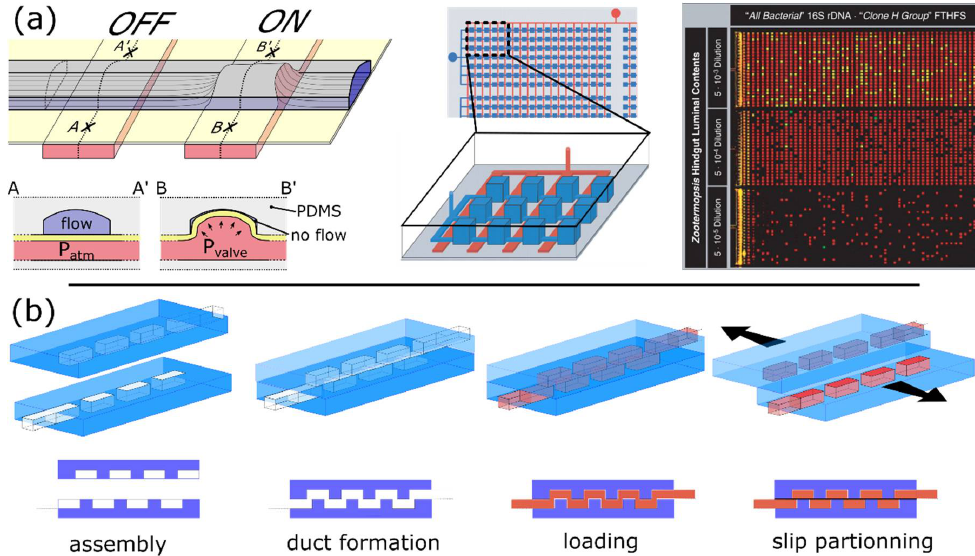
Figure 6. Active partitioning platforms. ( a ) Schematic of a push-up valve in a microfluidic chip made of PDMS. Left panel: The control channels (red) are separated from the fluidic channels (blue) by a thin flexible membrane (yellow). The flow through the fluidic channel is unobstructed if the control channel is not pressurized (OFF valve). When the control channel is pressurized, the thin PDMS membrane deforms and bulges into the fluidic channel, obstructing the flow (ON valve). As depicted in the bottom panel, a tight seal is obtained if the top of the fluidic channel is rounded. Central panel: Schematic diagram showing many parallel chambers (blue) connected through channels to a single input. The network of control channels (red) creates valves between each chamber allowing the partitioning of their content into independent PCR microreactors. Right panel: Three panels of 1176 chambers each, show the results of dPCR on samples harvested from a single termite ( Z. nevadensis ). (Figure adapted from [65] with permission.); ( b ) SlipChip device relies on two chip halves that contain arrays of open chambers. Temporary ducts or channels are formed when the two parts are aligned and put in contact while submerged in mineral oil. Sample and reagents are injected before the device is reconfigured by slipping. The slipping motion creates arrays of independent microreactors. The device can be further slipped to bring the two independent arrays (containing reagent and sample) in contact to trigger mixing (not shown). (Figure adapted from [66] with permission.) In contrast to these active strategies, partitioning with this format can be performed passively by using an overlay of immiscible oil after loading of the aqueous phase into the microwells. The oil phase preferentially wets the top of the array and creates a meniscus that displaces the aqueous phase; however, the oil/aqueous phase/solid triple line gets pinned at transitions between hydrophobic and hydrophilic areas [58,67]. The liquid-liquid interface then extends from the pinned triple line until it reaches another hydrophobic patch where another propagating triple line will be created [68]. The oil progresses on the hydrophobic surface of the array and around the well orifices to generate a sweeping motion that displaces the excess of aqueous phase. Pinning also exists when a triple line encounters an abrupt change of topology or channel direction [69,70]. Pinning can thus be used to isolate dead-end chambers within a microfluidic network thanks to the topology of the main channel and the chambers (Figure 7a) [37]. In this configuration, the oil film gets pinned at the chamber orifices. This strategy greatly increases the chamber density by reducing the size of the main channel compared to microfluidic valves that require a minimum span or width to be efficiently deformed. This method resulted in the generation of up to 1 million partitions in the pL range with a standard deviation of the volume equal to a few percent [37]. The very high number of partitions allows unparalleled precision and a theoretical dynamic range of up to 7 logs. In addition to a much higher density of chambers, the strategy requires a simpler fabrication process than pneumatic valves.